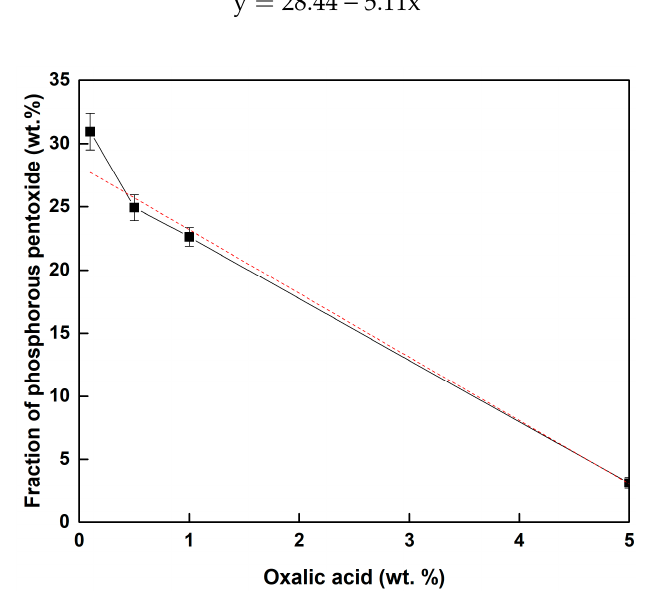
Figure 4. The fraction of phosphorous pentoxide for the HTC product ash with the weight fraction of oxalic acid.